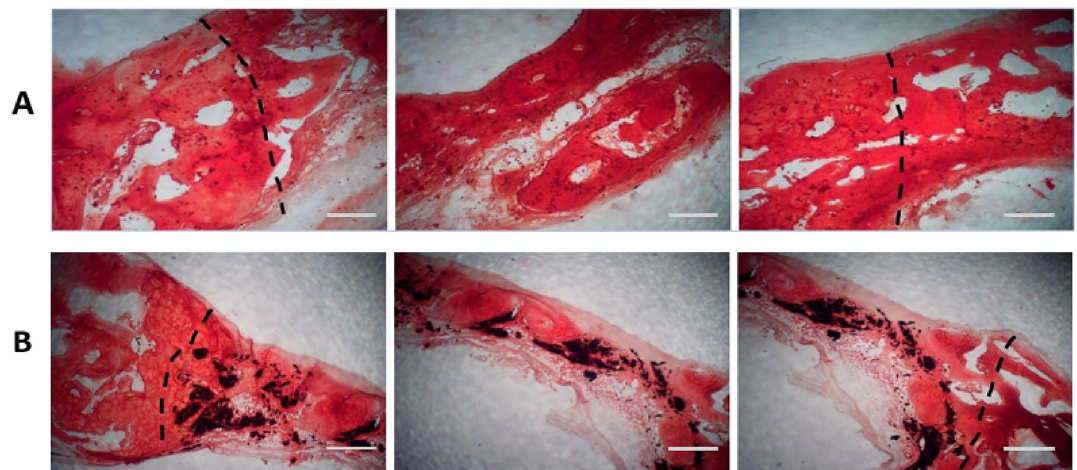
Figure 8. Histological findings after 12 weeks; Alizarin Red stain of the bone defects area repaired by Col ( A ) and Col-rGO ( B ) scaffolds. Images for each group were illustrated from three different parts of the same location. The dotted line indicates the border between intact bone and scaffolds. Scale bar 100